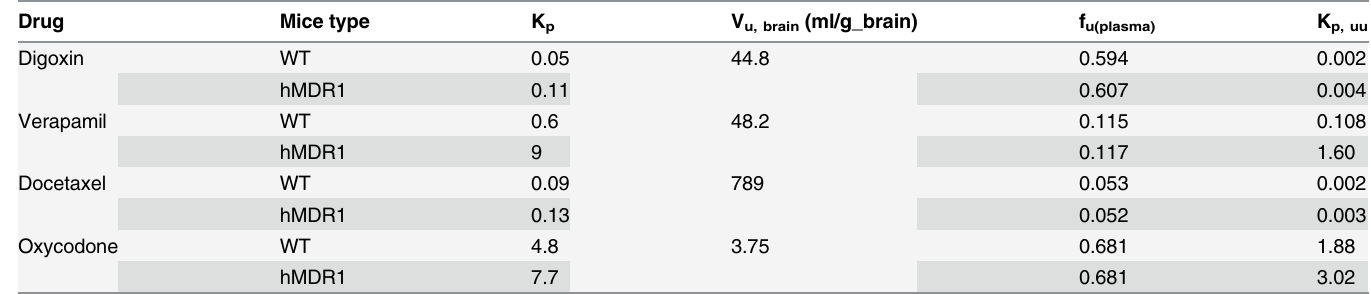
Table 1. K p, uu values of the C57BL/6 WT mice (WT) and hMDR1 mice calculated using V u, brain and f u, plasma measured with the brain slice method and equilibrium dialysis respectively.